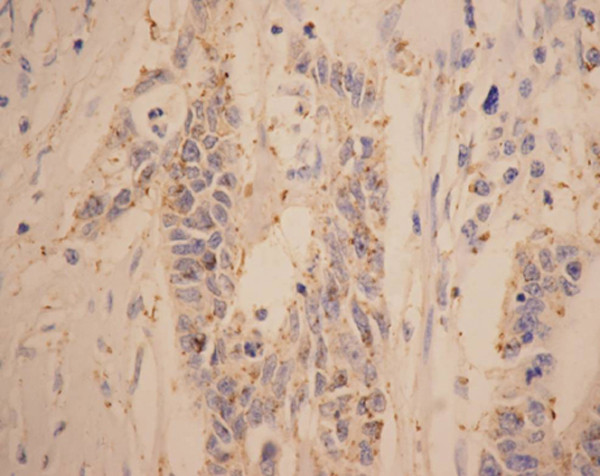
Staining of immunohistochemistry of HIF-1α (EnVision, ×400). HIF-1α expression showing mixed nuclear and cytoplasmic staining.